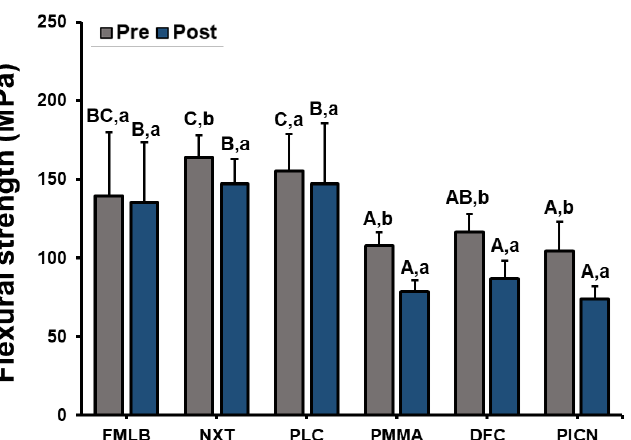
Figure 7. Flexural strength results of six materials pre and post toothbrushing. A significant difference in flexural strength between materials is indicated by different upper-case letters, and a significant difference in flexural strength between pre and post artificial toothbrushing is indicated by different lower-case letters ( p < 0.05).